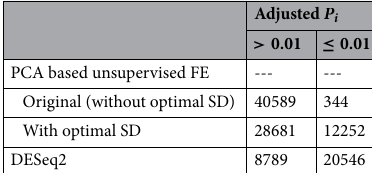
Adjusted P i > 0.01 ≤